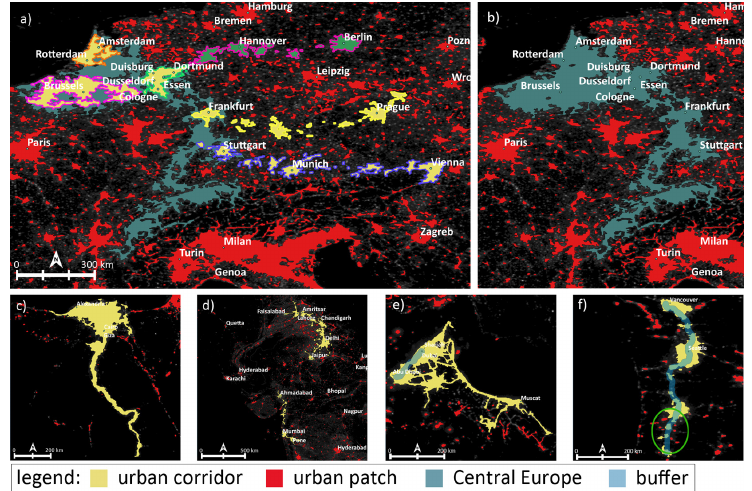
Figure 8. ( a ) Central Europe (blue) with subcorridors RhineRuhr, Randstad, Flemish Diamond, Stuttgart–Vienna and Frankfurt–Prague (right); ( b ) Central European corridor; ( c ) Nile Valley; ( d ) India: Delhi Region and Mumbai–Ahmadabad; ( e ) large night-lit patch from Abu Dhabi and Dubai extending south-east; ( f ) patches omitted from the Cascadia urban corridor (green circle).